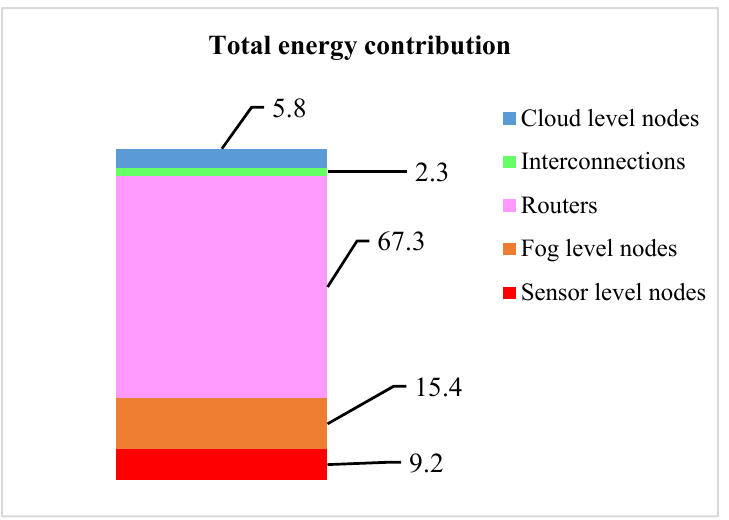
Figure 13. Energy consumption contribution of the different. Simulated components of IoT for application 2.